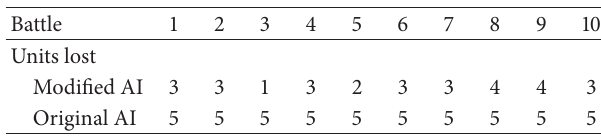
Table 1: Units lost in each battle for each group with the modified and original unit